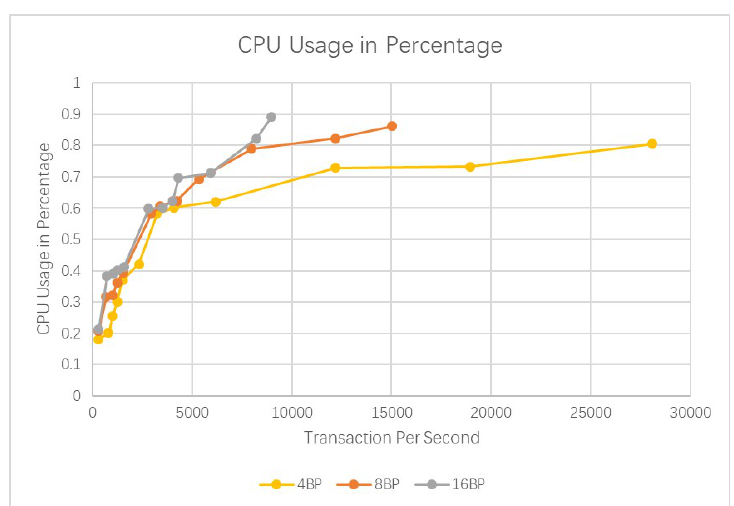
Figure 9. Comparison of the CPU usage in percentage.